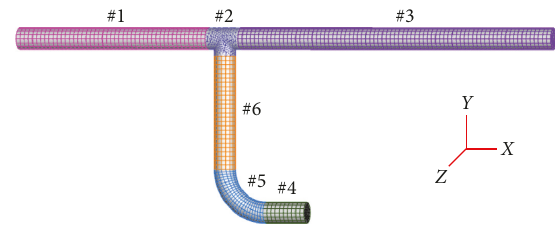
Figure 4: Region division.